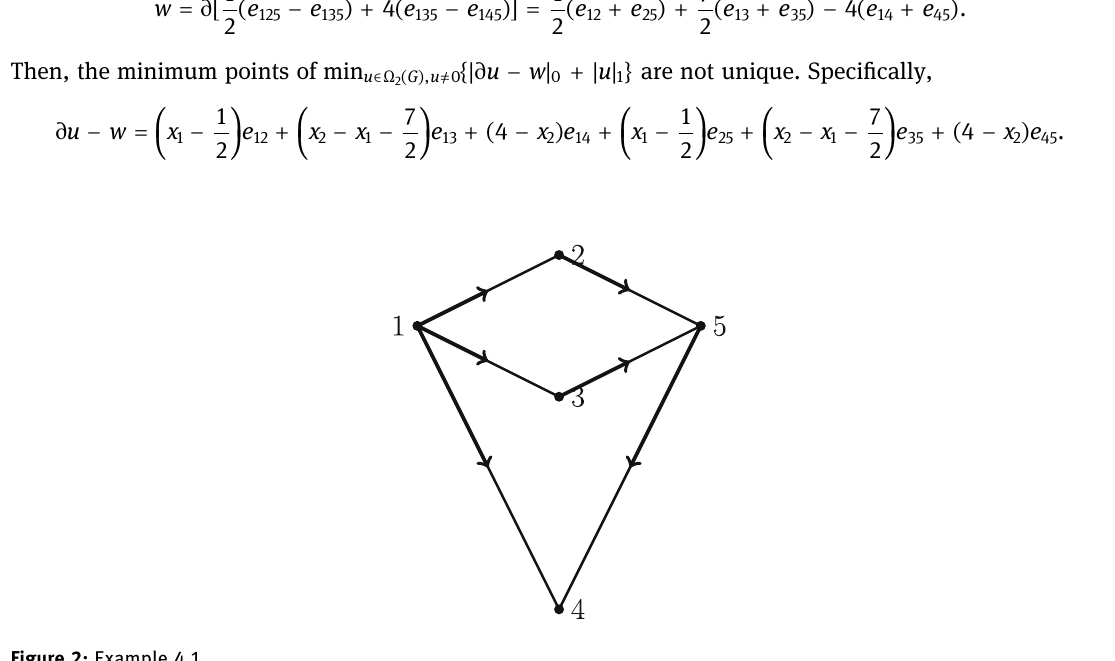
Figure 2: Example